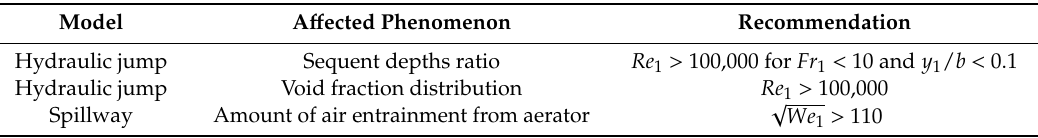
Table 2. Recommendations to avoid significant scale e ff ects by Heller